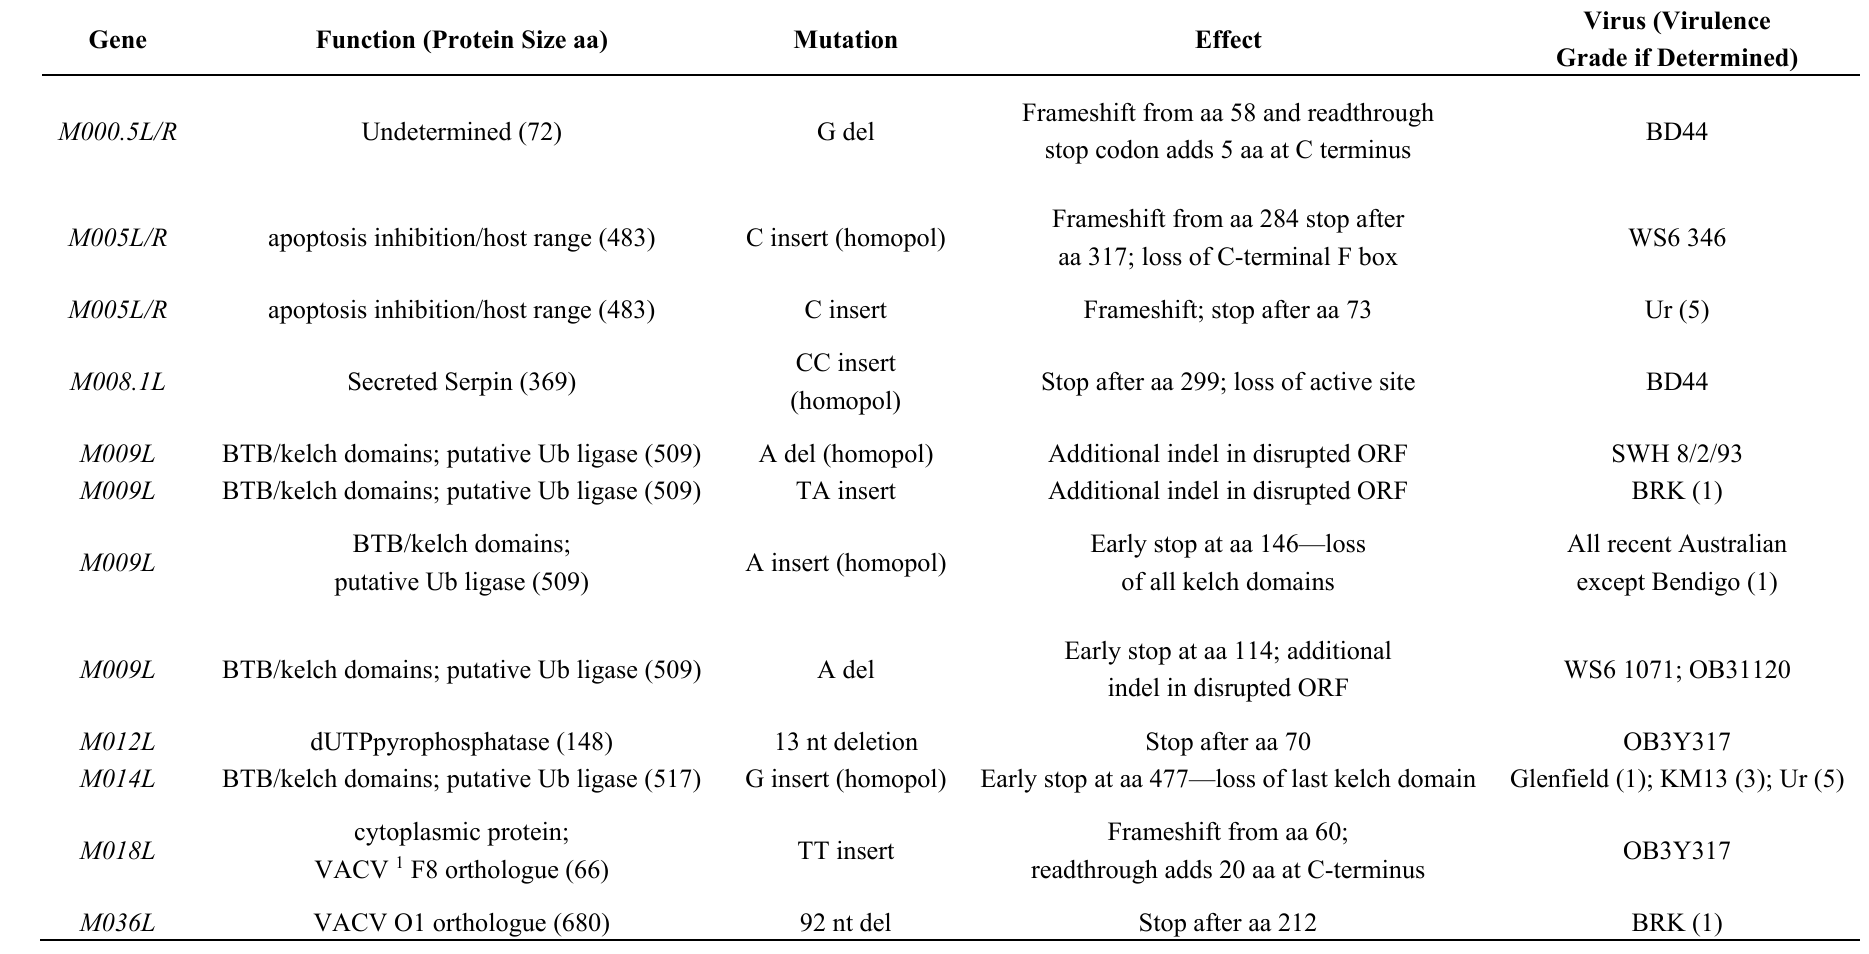
Table 6. Indels disrupting coding regions of MYXV isolates from Australia and Britain